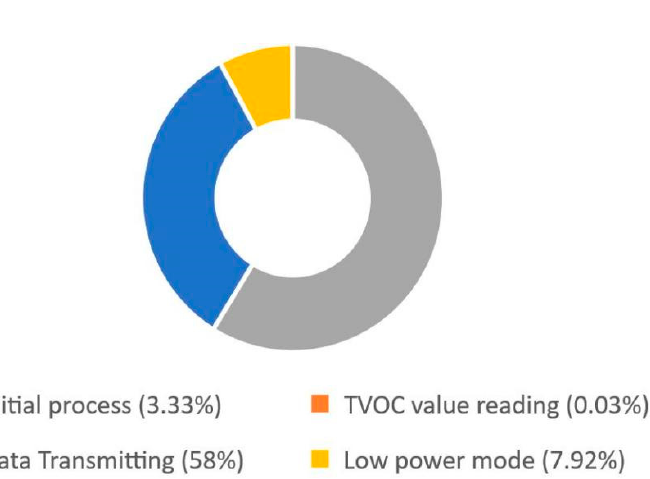
Figure 12. Power source capacity percentage.